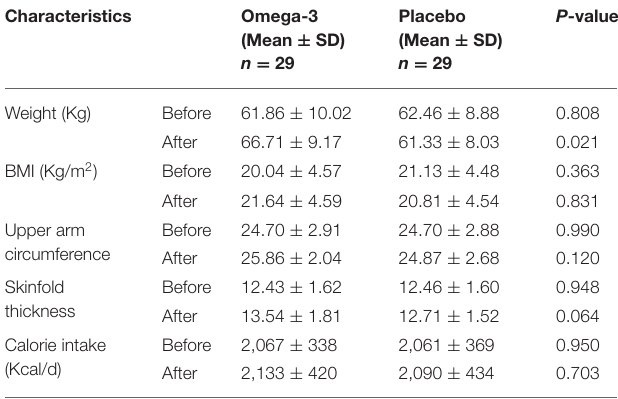
TABLE 2 | Anthropometric outcomes of patients with lung cancer in omega-3 fatty acid supplementation and placebo